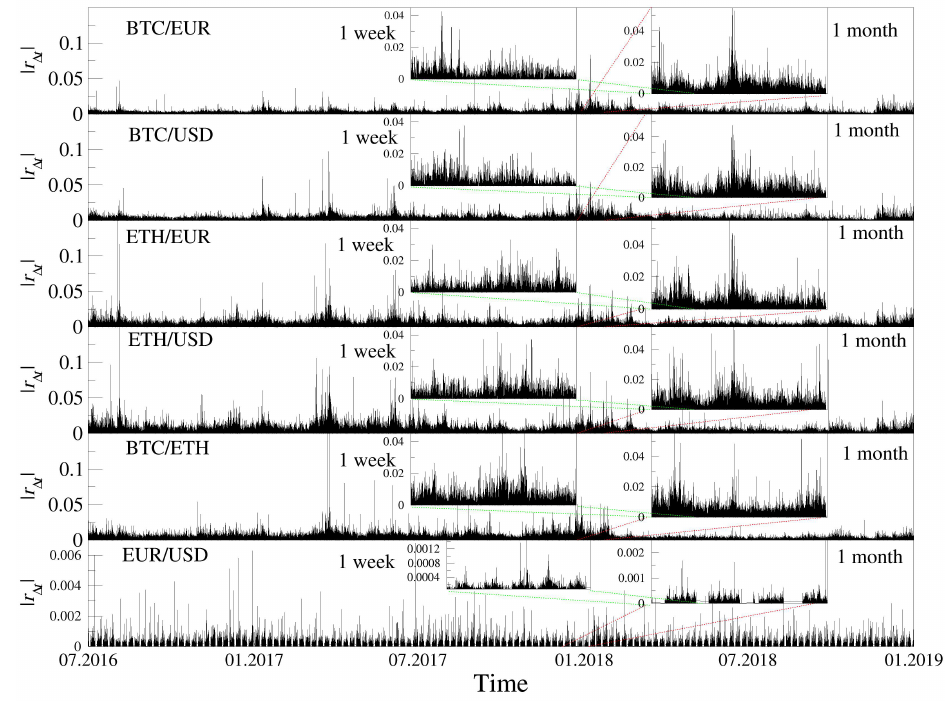
Figure 2. (Color online) Time-variation of the moduli of ∆ t = 10 s logarithimic returns corresponding to the exchange rates of BTC/EUR, BTC/USD, ETH/EUR, ETH/USD, BTC/ETH and EUR/USD over the period between 1 July 2016 and 31 December 2018. The insets provide magnifications of the time-spans